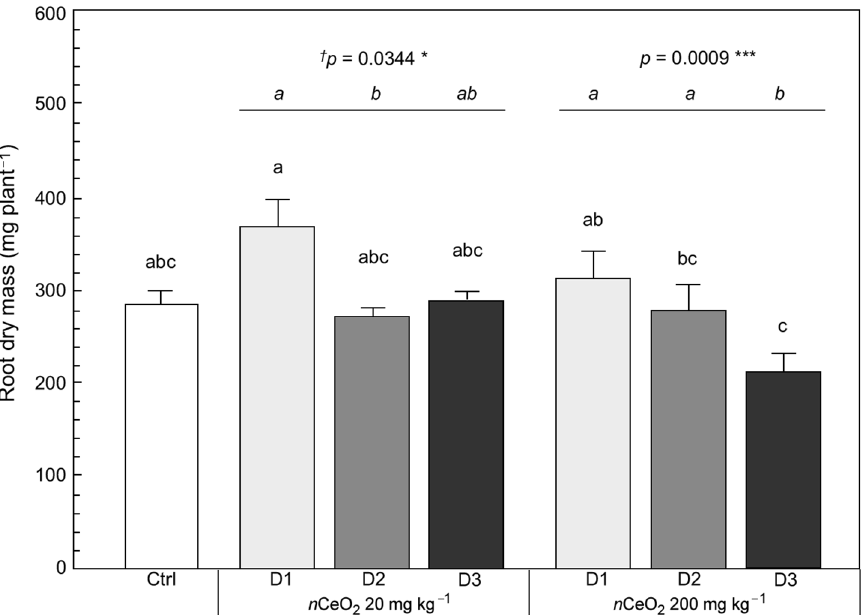
Figure 4. Root dry mass of S. flos cuculi . Comparison of effects based on single (D1) and repeated (D2, D3) applications of 20 and 200 mg kg − 1 n CeO 2 , respectively. Letters indicate statistically significant difference between treatments ( p ≤ 0.05) using one-way ANOVA followed by Tukey’s test. † One-way ANOVA p -value within each concentration: asterisks indicate the statistically significant difference of dose factor at * 0.05 ≥ p ≥ 0.01; ** 0.01 ≥ p ≥ 0.001; *** p ≥ 0.001, respectively.